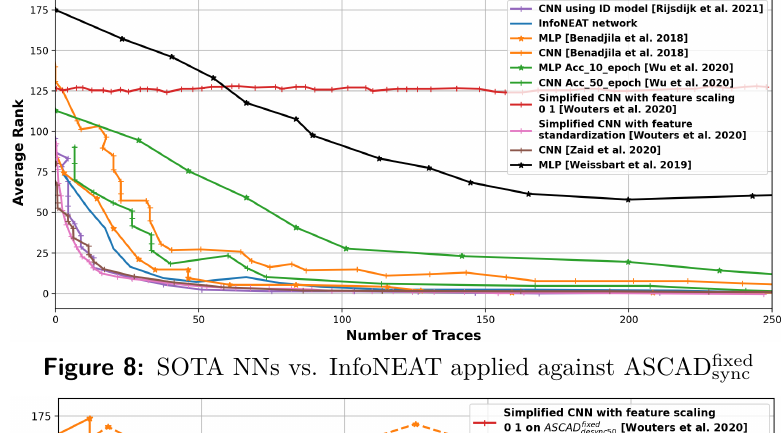
Figure 8: SOTA NNs vs. InfoNEAT applied against ASCAD fixed sync